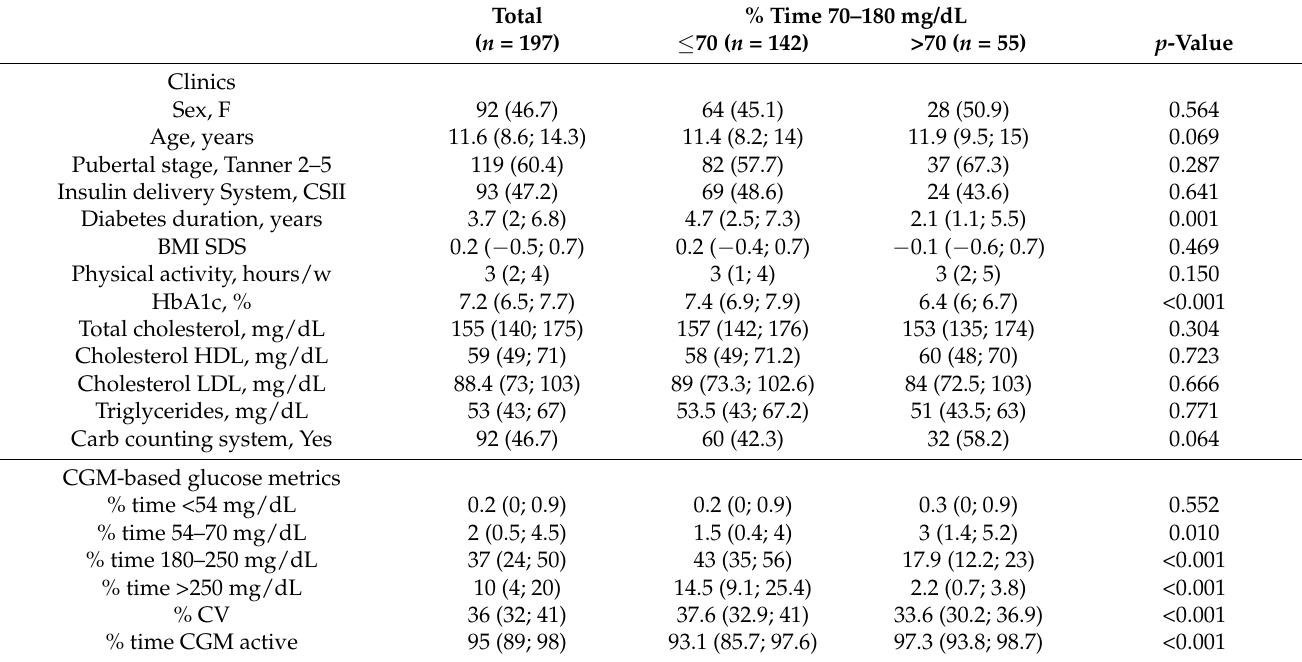
Table 1. Clinical characteristics according to percentage of time in